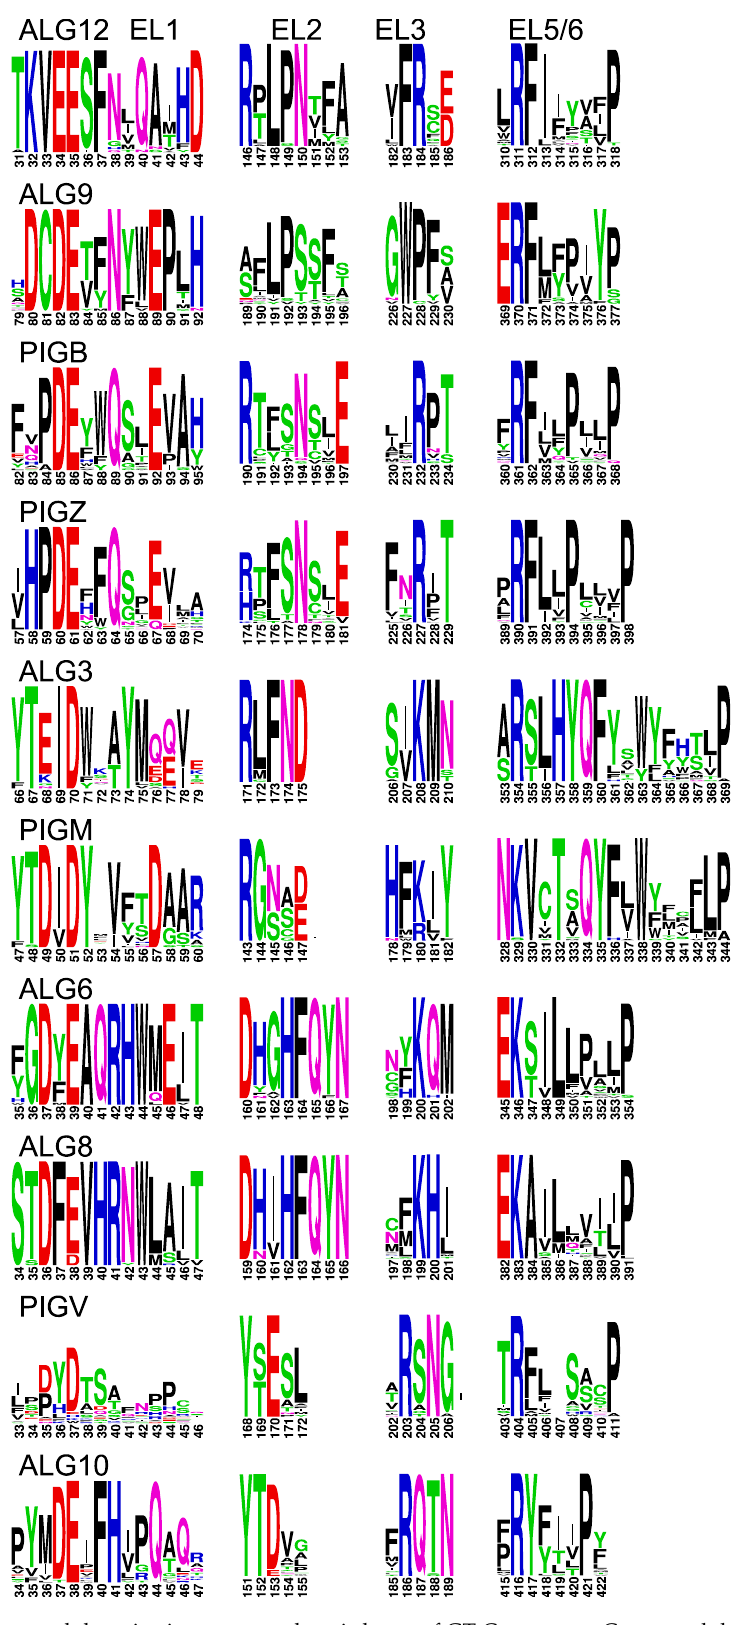
Figure 6. Conserved domains in extracytoplasmic loops of GT-C enzymes. Conserved domains in EL1, EL2, EL3, and EL5 (EL6 for ALG10) of indicated GT-C members, presented as logos. The positions correspond to arrows in Figure 5.